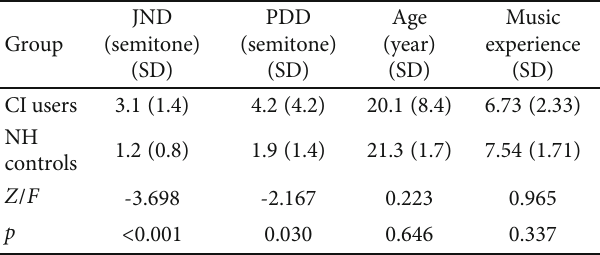
Table 2: Statistical results for age, music experience, and pitch discrimination scores for the two study